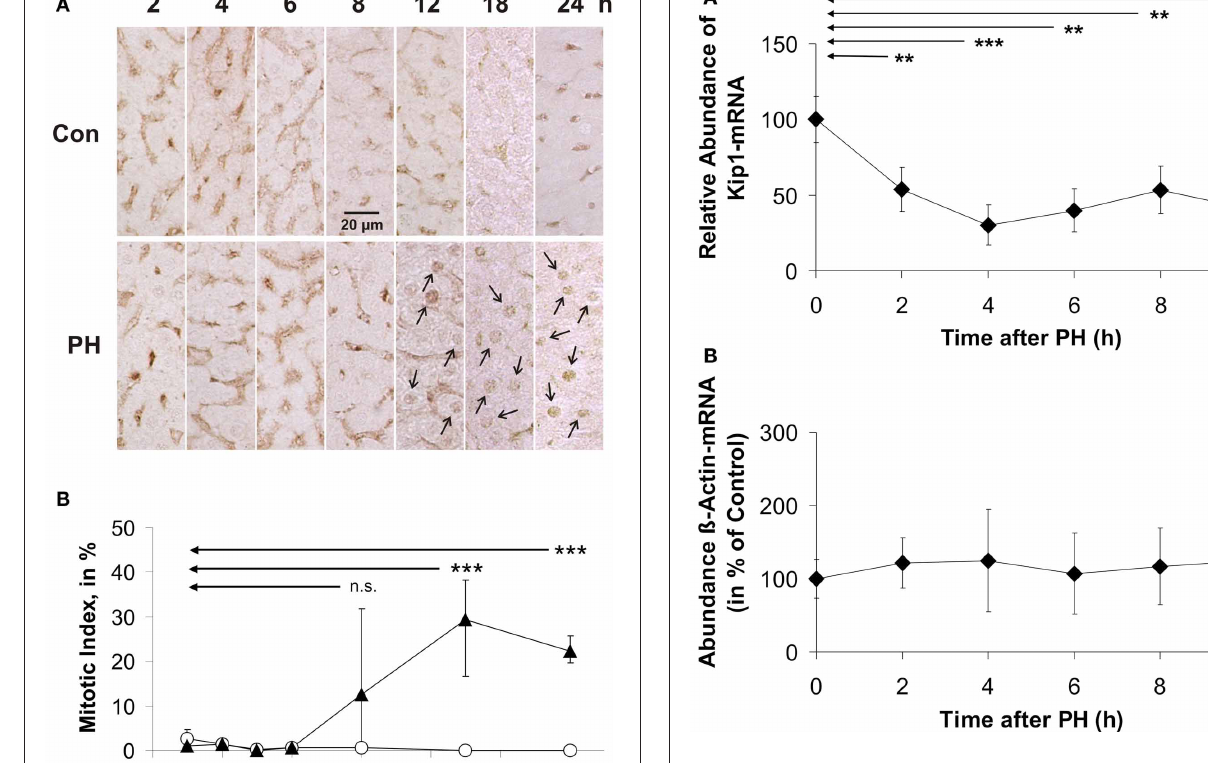
FIGURE 2 | Abundance of Kip1- (A) or β -actin (B) mRNAs in residual liver tissue at different times after partial hepatectomy. (A) Data represent differences of the (cid:2) Ct-values ( (cid:2)(cid:2) Ct-method) of Kip1- and β -actin-specific qPCR-signals. (B) Data represent densitometric signals obtained from dot blots using equal amounts of total RNA extracted from the tissue samples hybridized to a digoxigenin-labeled β -actin-specific probe. Data are expressed as percentages of the control values at 0h. The data points represent means ± SD of n = 4 different preparations of tissue, each analyzed at least in triplicate ( ∗∗ p < 0 . 01; ∗∗∗ p < 0 . 001). No significant differences in β -actin mRNA abundance were detected in residual liver tissue of hepatectomized animals (B) . ( Figure 4 , insert, arrow), while only background staining